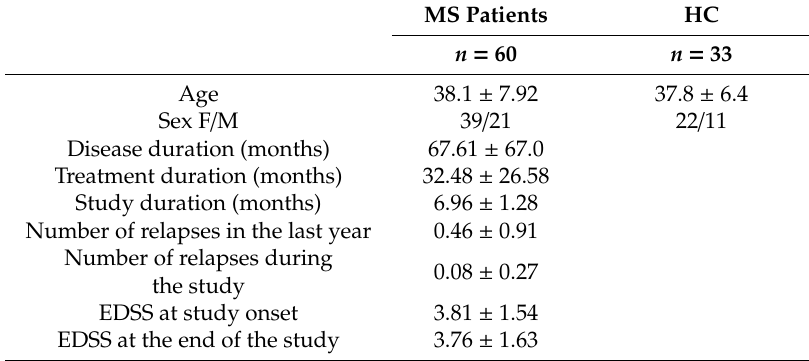
Table 1. Demographic and disease-related data for multiple sclerosis (MS) patients and healthy controls